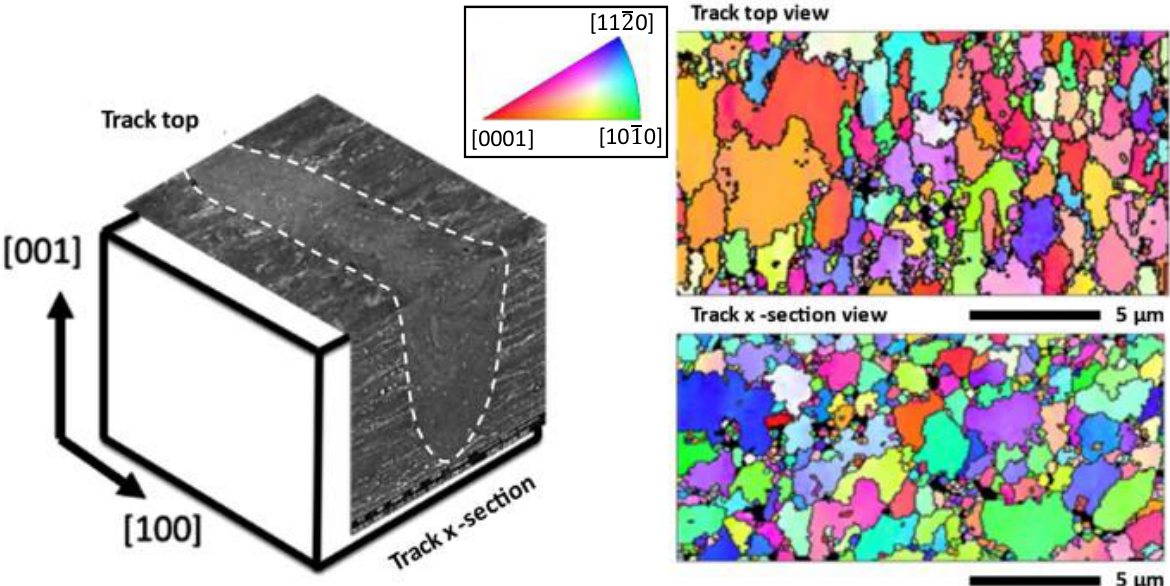
Figure 8. Electron backscatter diffraction (EBSD) data collected from the melted region of a cross- sectioned single track irradiated at P = 300 W, v = 750 mm/s. The left panel shows the orientation of the two orthogonal views with the solidified melt pool indicated by the dashed line. Top and cross- section EBSD images are presented to the right, illustrating an isotropic grain structure.